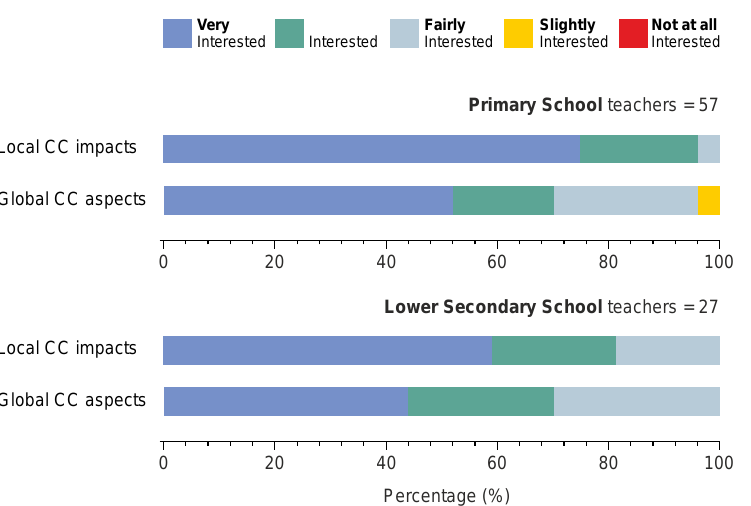
Figure 5. Level of interest for local or global aspects of CC between primary school teachers (upper panel) and LSS teachers (lower panel).